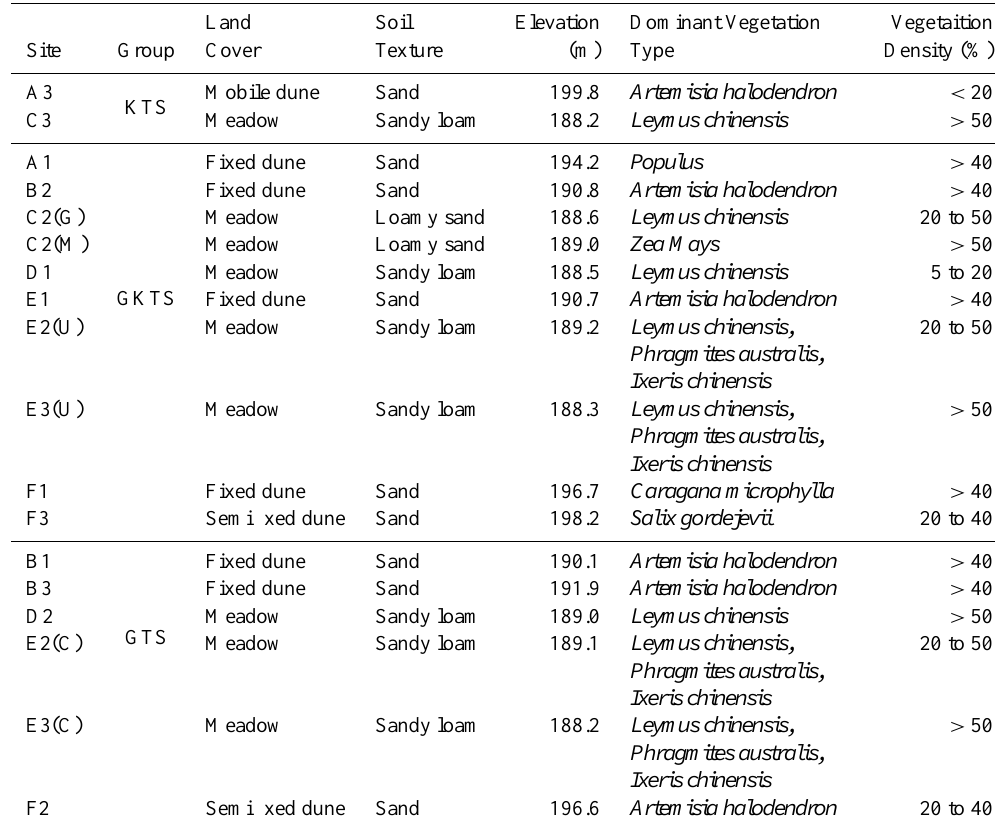
Table 2. Characteristics of the hydrological measurement